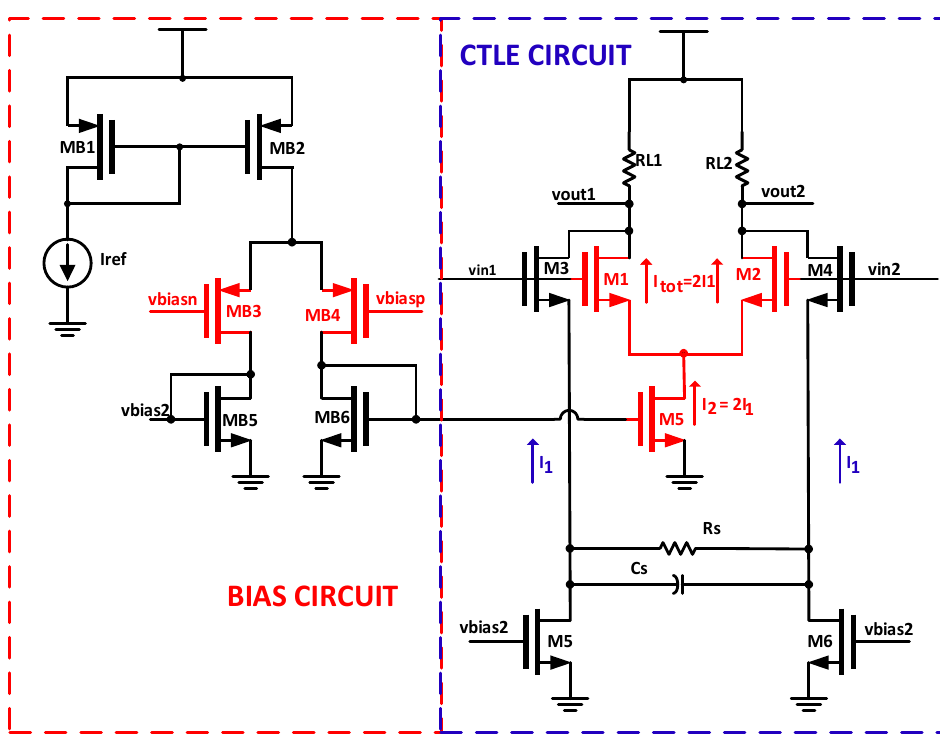
Figure 4. Schematic of Proposed CTLE.